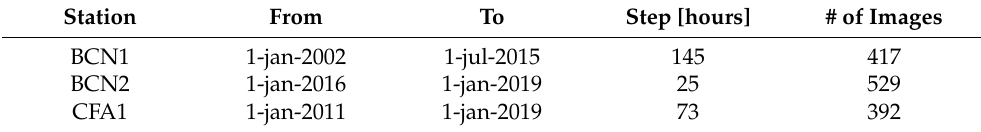
Table 2. Pool of images: initial and final dates, time step and resulting number of images. Station From To Step [hours] # of Images